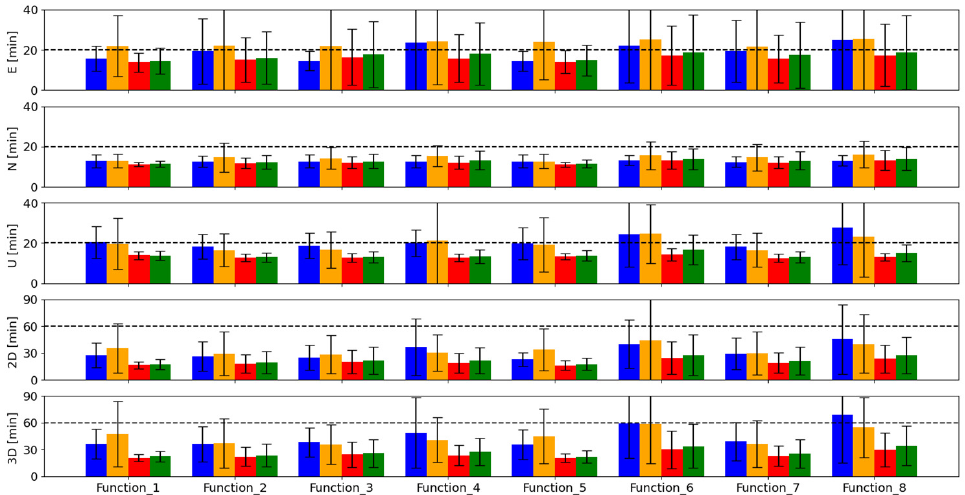
Figure 9. Mean convergence time with standard deviation from all stations and all periods for all analyzed weighting functions. Blue − E solution, orange − G solution, red − GE solution, green − GE1 so- lution.